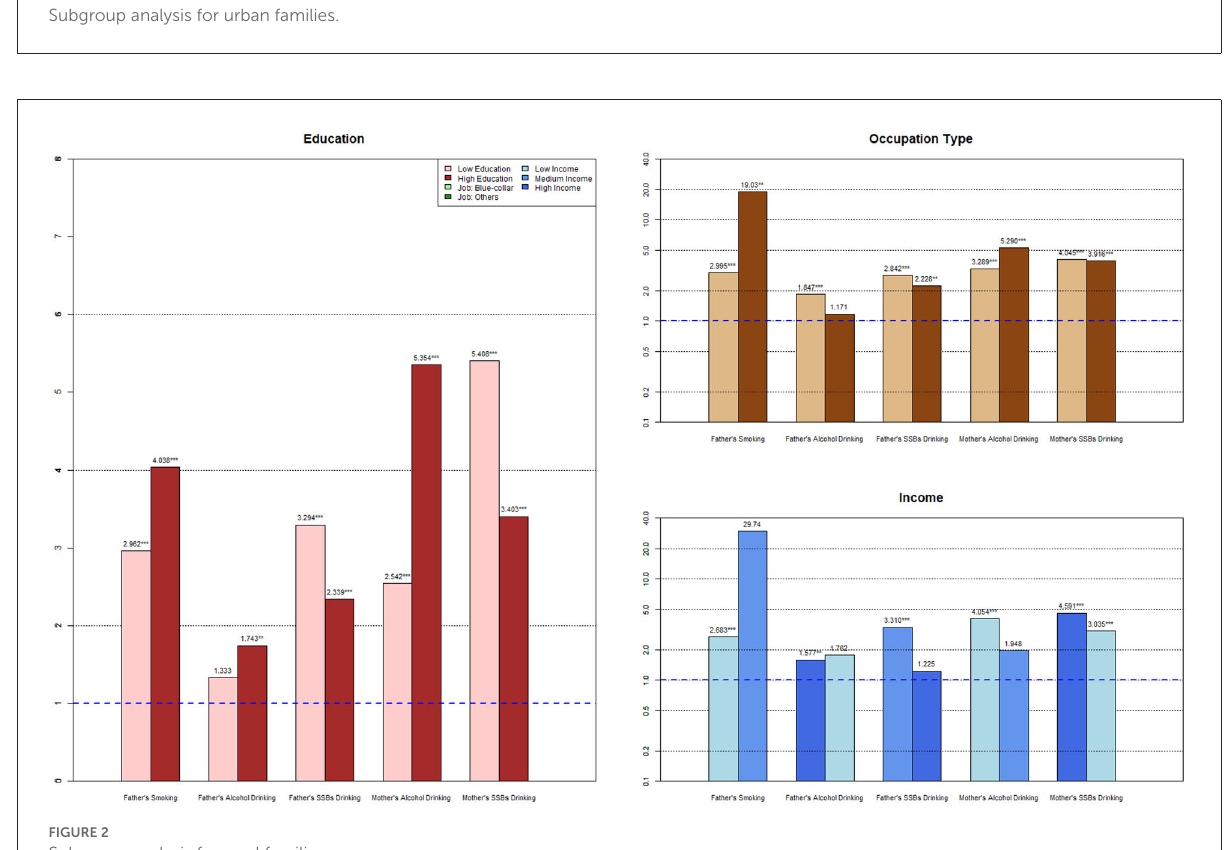
FIGURE1 Subgroup analysis for urban families.